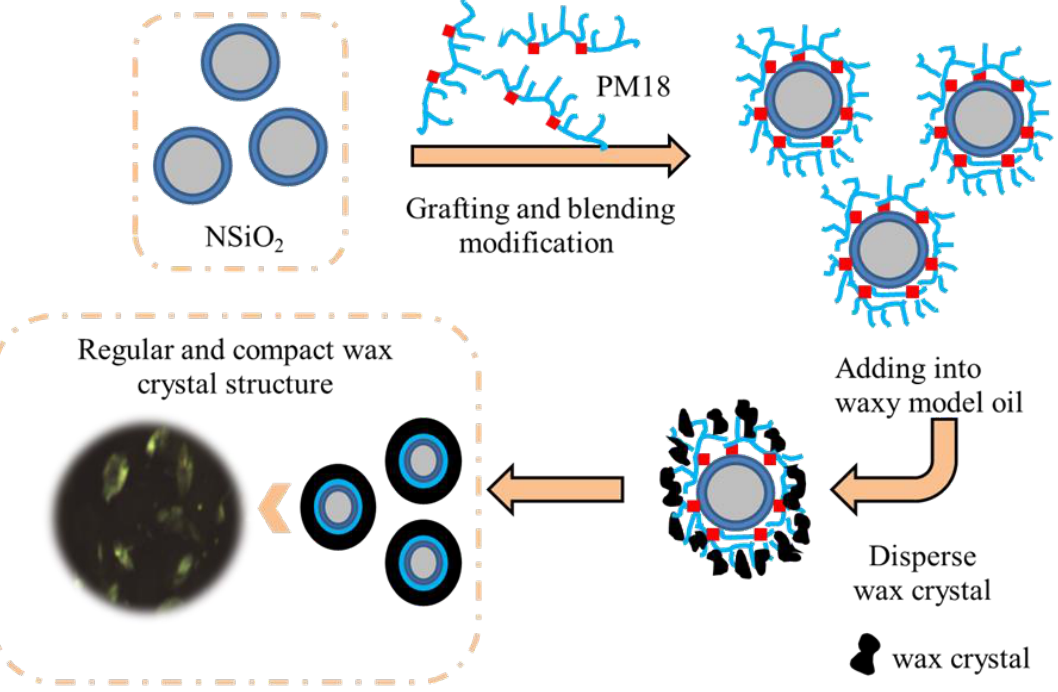
Figure 7. Schematic diagram of the flow improving mechanism of PM18-g-NSiO 2 on waxy model oil.